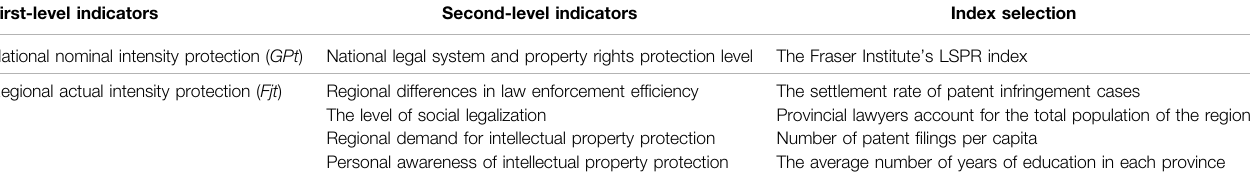
TABLE 3 | De fi nitions of major variables.